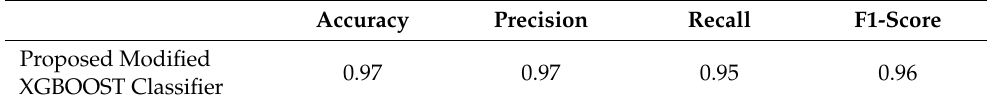
Table 1. Performance metrics of the Modified XGBoost Classi fi er.